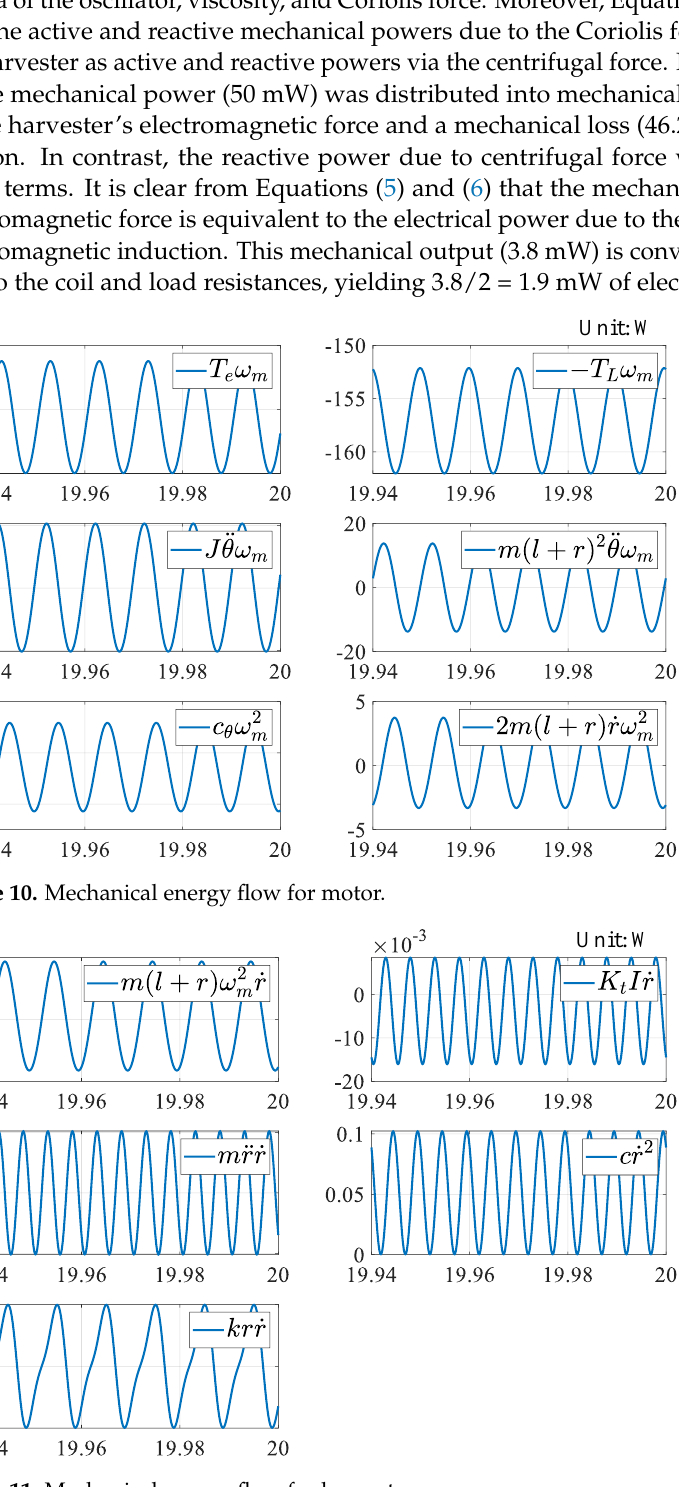
Figure 11. Mechanical energy flow for